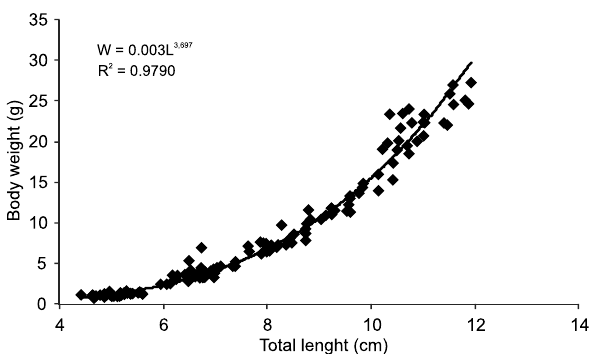
Figure 1. Length-weight relationship of market size cultivated fe- male Astyanax aff. fasciatus .